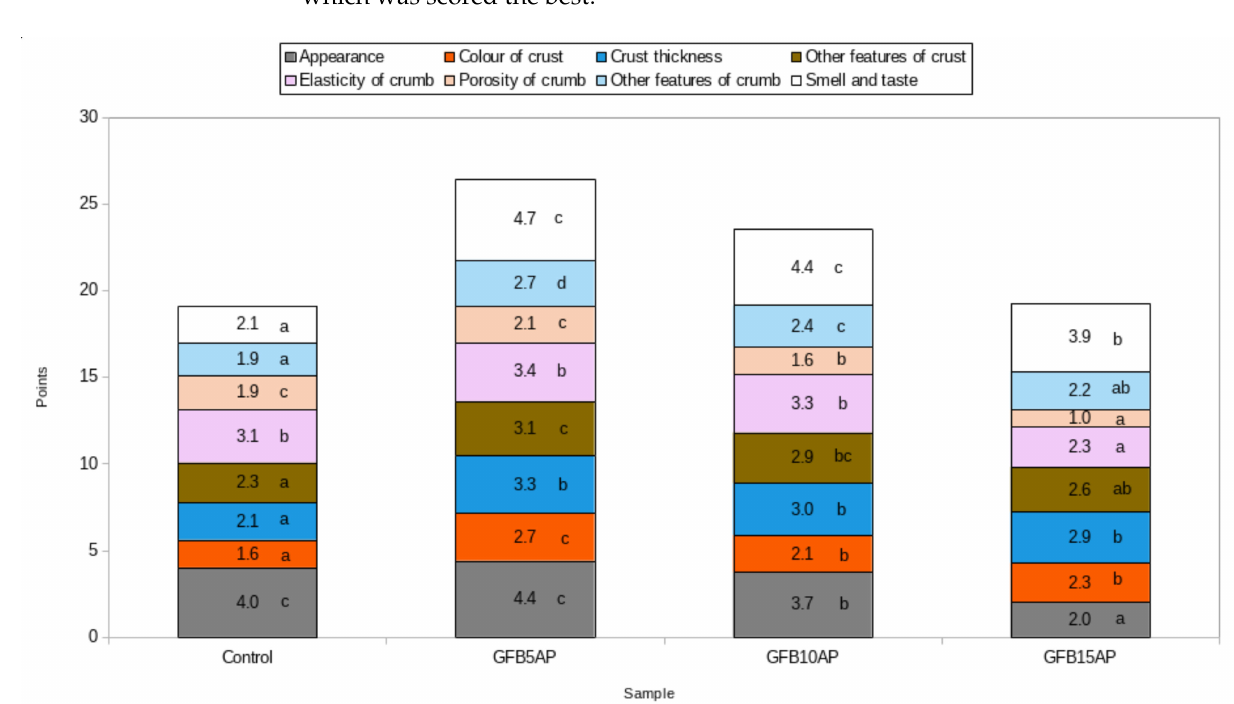
Figure 1. Organoleptic evaluation of gluten-free breads with apple pomace (values signed the same letters a–d in particular colors are not significant at 0.05 level of